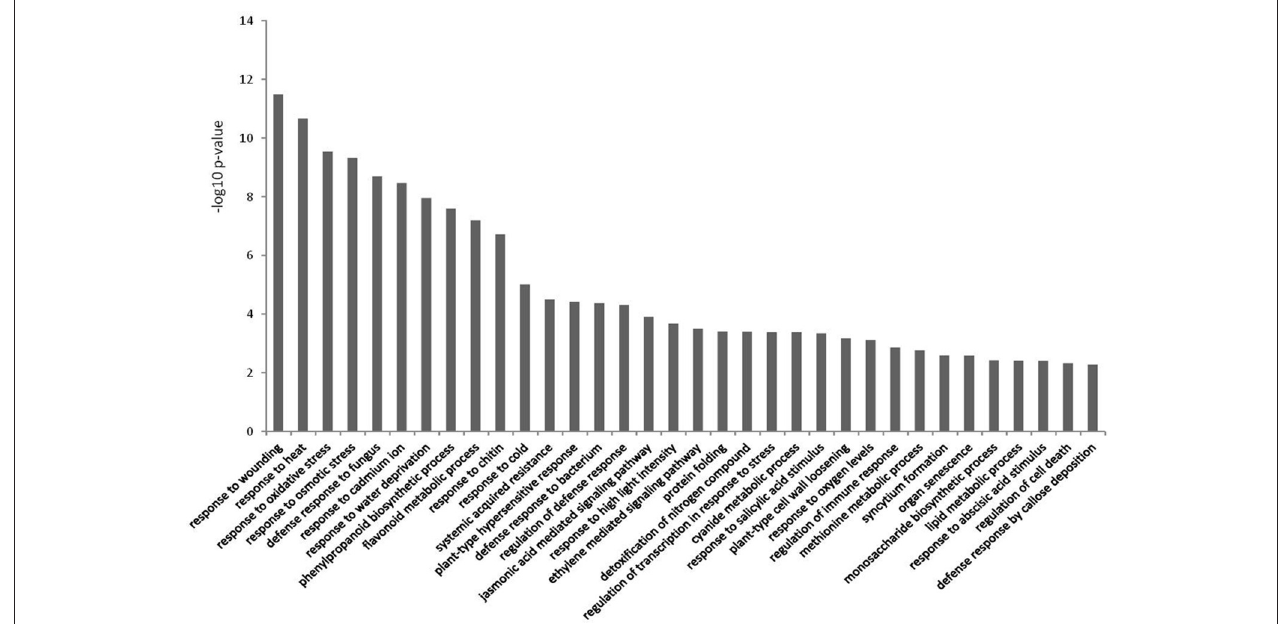
FIGURE 4 | Over-represented Gene Ontologies in the category biological process for the genes up-regulated in response to Phytophthora cinnamomi challenge in Eucalyptus nitens at 5 dpi.